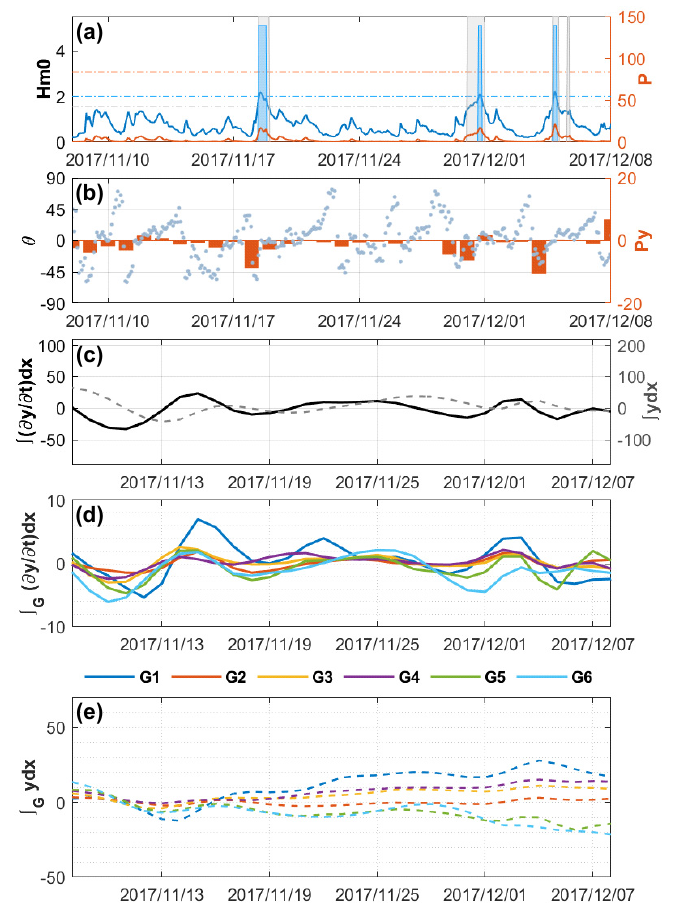
Figure 13. Changes in wave and beach parameters during November 2017. ( a ) Significant wave height and wave power, ( b ) wave direction and longshore component of wave power, ( c ) longshore transport rate (solid line) and integrated beach width (dashed line), ( d ) longshore transport rate for each sector, and ( e ) integrated beach width for each sector.